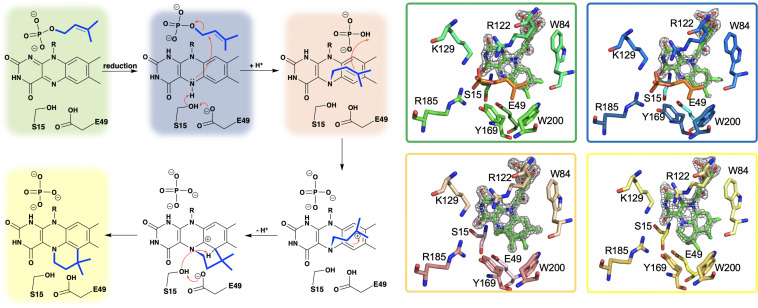
A hypothetical chemical mechanism for UbiX/Pad1 and supporting crystal structures of UbiXox⋅DMP (dimethylallyl monophosphate) complex (PDB code 4ZAF, green), UbiXred⋅IMP (isopentyl monophosphate) complex (PDB code 6QLH, blue), UbiX-dimethylallyl monophosphate adduct (PDB code 4ZAV, tan), and UbiX⋅FMNpren complex (PDB code 4ZAW, yellow).